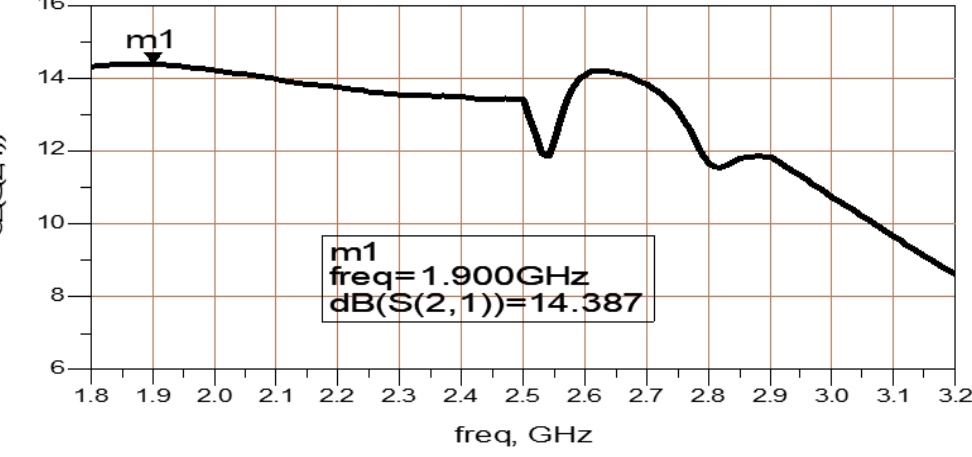
Figure 16. Gain, S21, of the Active Transmitting Circular Polarized Antenna. The 1 dBc output power of the transmitting sensor is around 17 dBm to 19